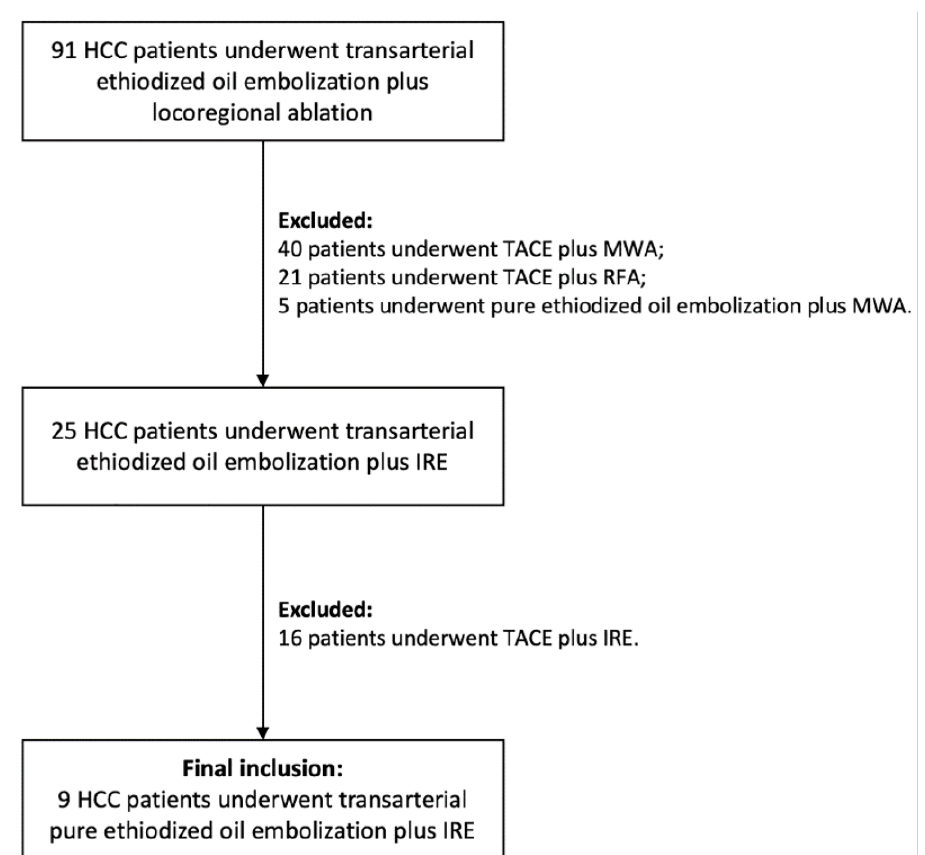
Figure 3. Flowchart of patients